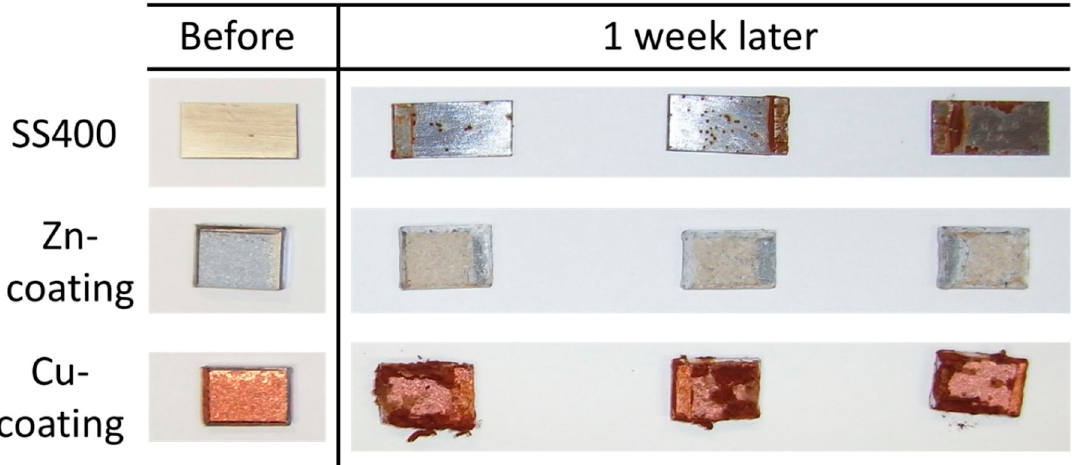
Figure 10. Digital photometric images of the surface of LBR-immerged coupons.